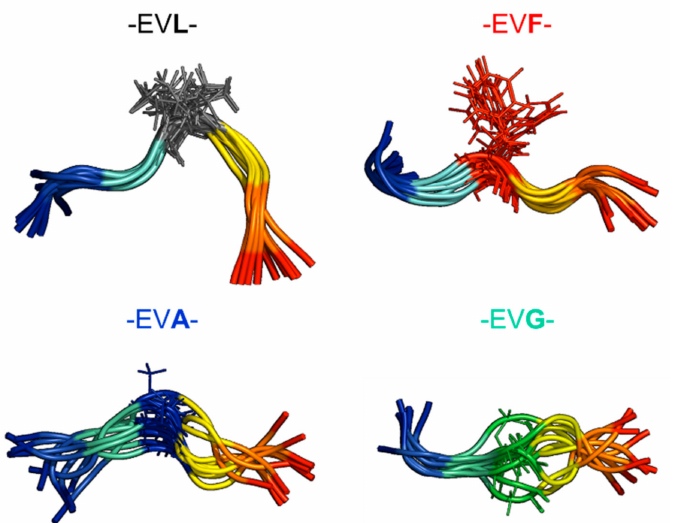
Figure 2. Representative NMR determined structures. An ensemble of the ten lowest energy structures of the peptides was determined using NMR methods. The respective tri-peptide motifs are shown on the top of each ensemble, and the central residues are shown in stick representation with a different color.